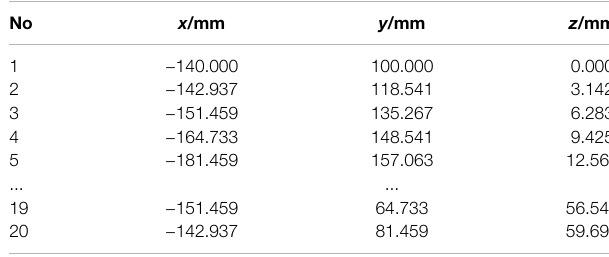
TABLE 2 | Positions of every sample points.